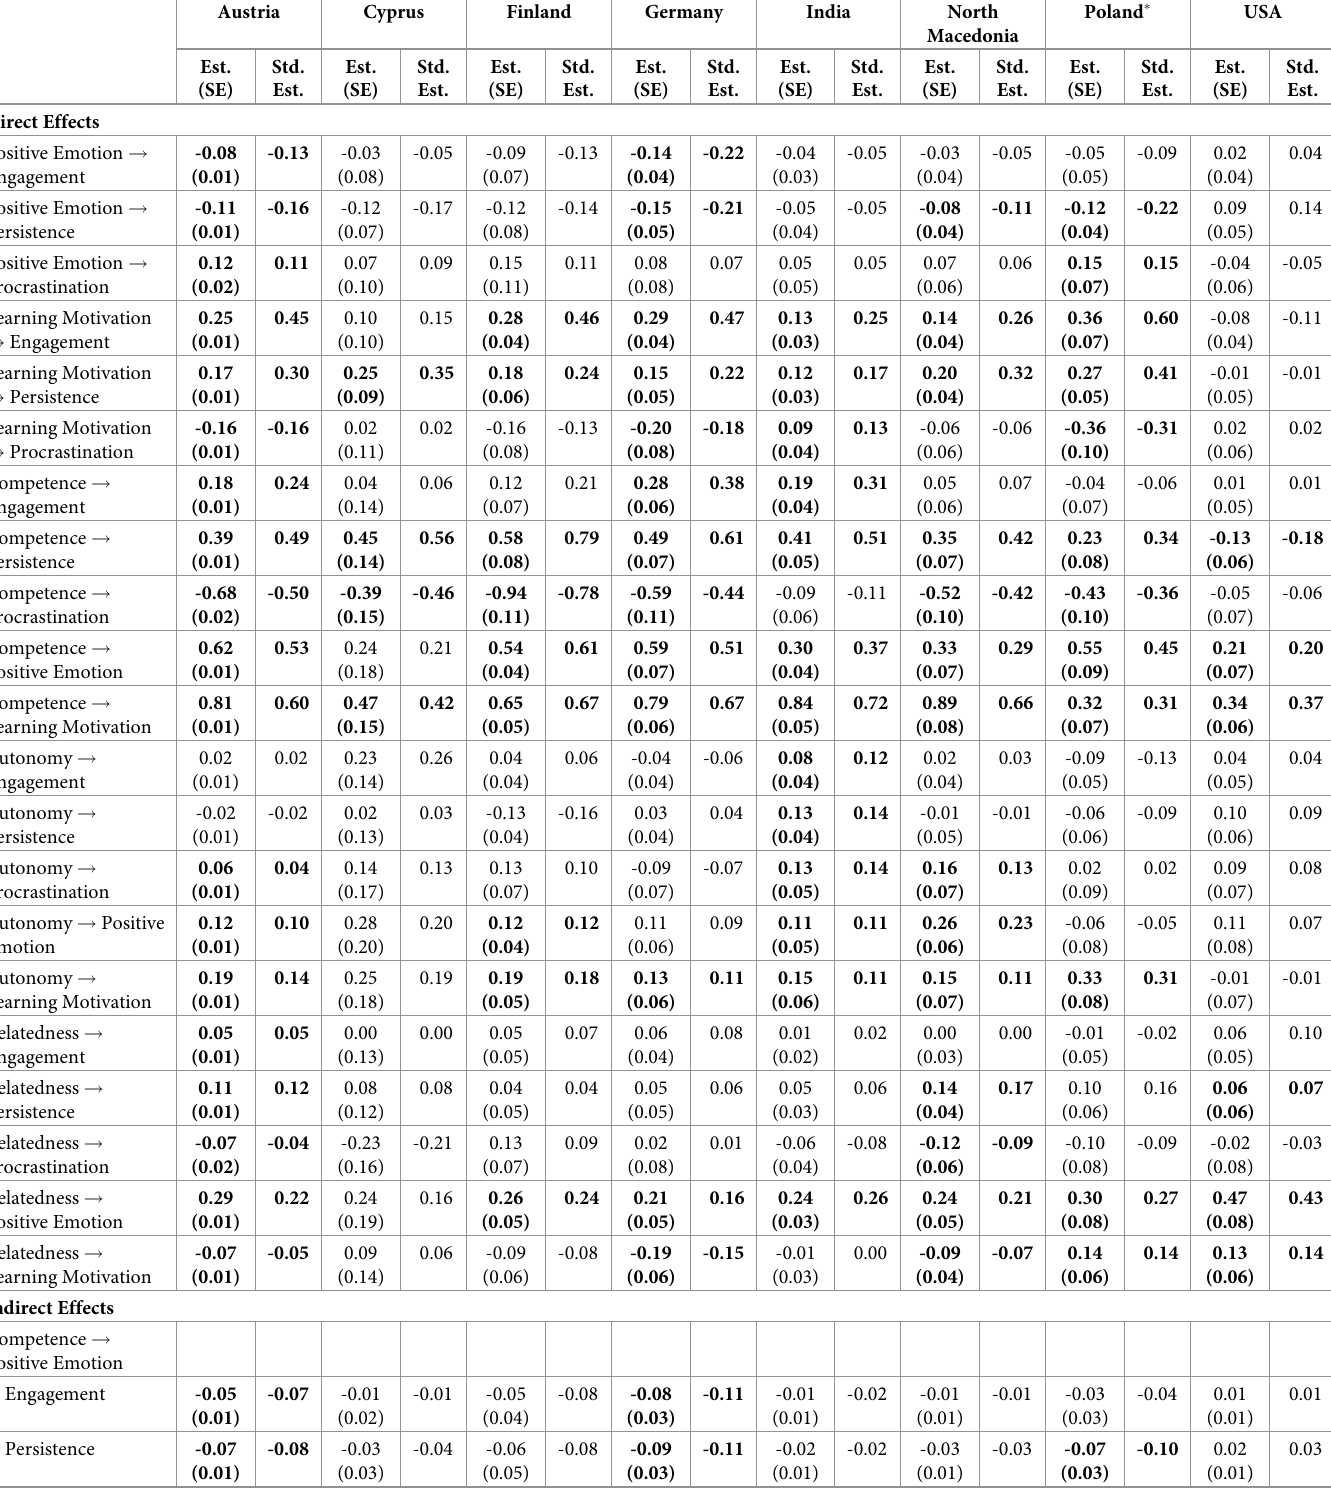
Table 5. Results of mediation analyses, i.e., direct and indirect effects, and explained variance by the models for each country of data collection.